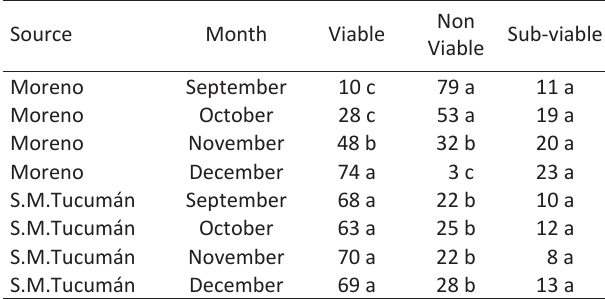
Values with different letters between the same column are signifi- cant different. Tukey (p≤0.05). Table 2 - Viability of pollen grains collected on September from anthers of the same flower